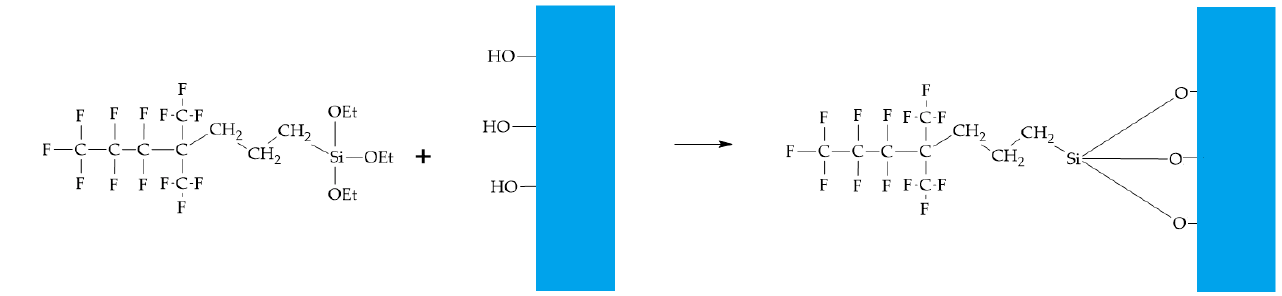
Figure 4. Modifier attachment to hydroxyl-containing surfaces mechanism. The FT-IR spectra of glass microspheres are shown in Figure 5. The adsorption band of 1,1,1,2,2,3,3-heptafluoro-4,4-bis(trifluoromethyl)pentyltriethoxysilane modifier